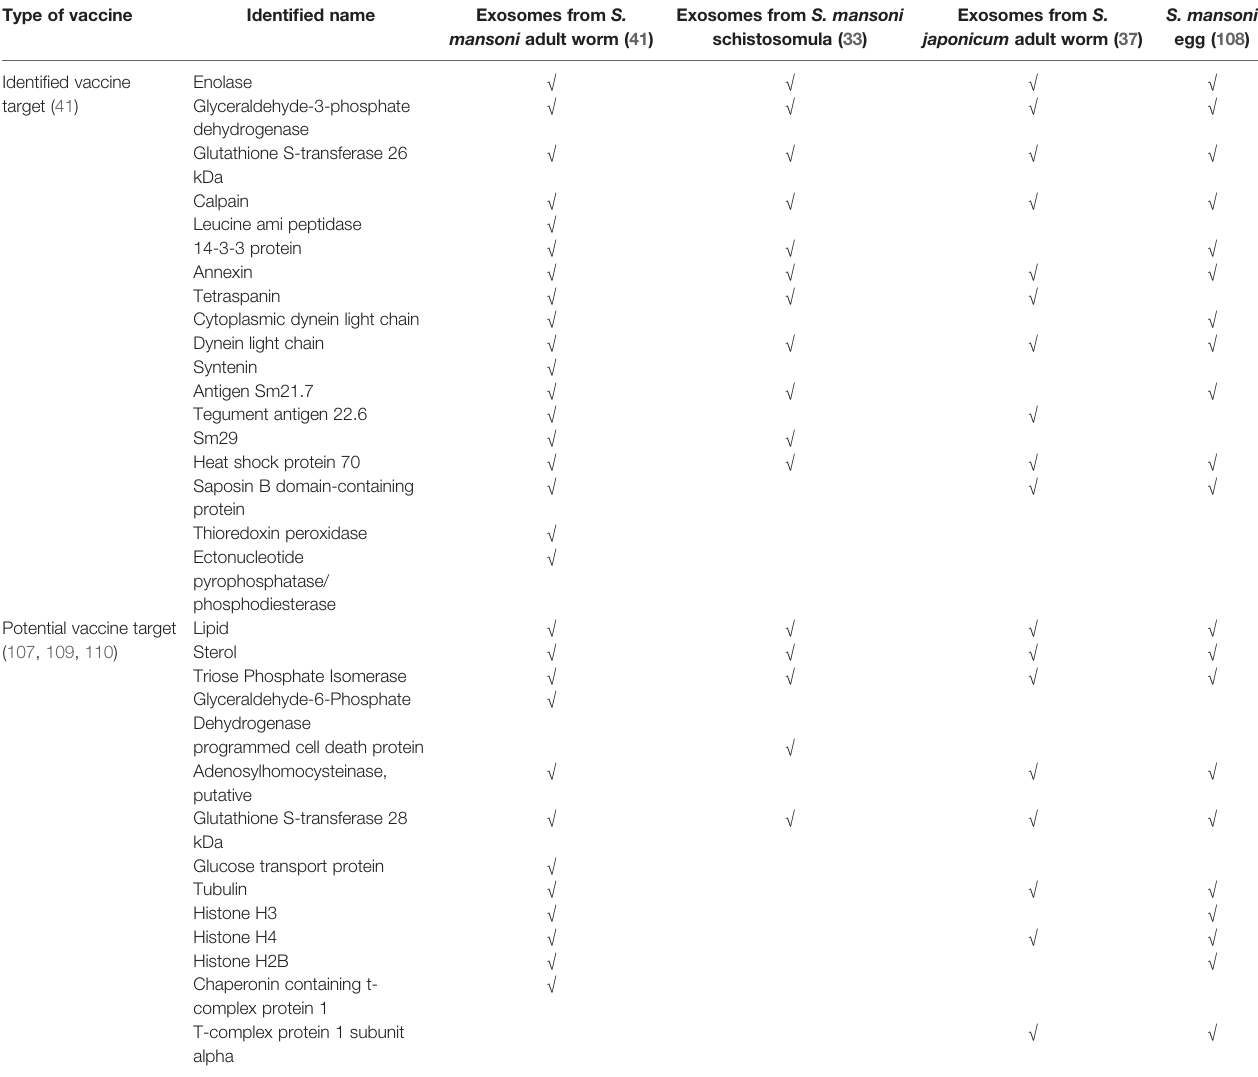
TABLE 3 | Exosomal substances as potential vaccine